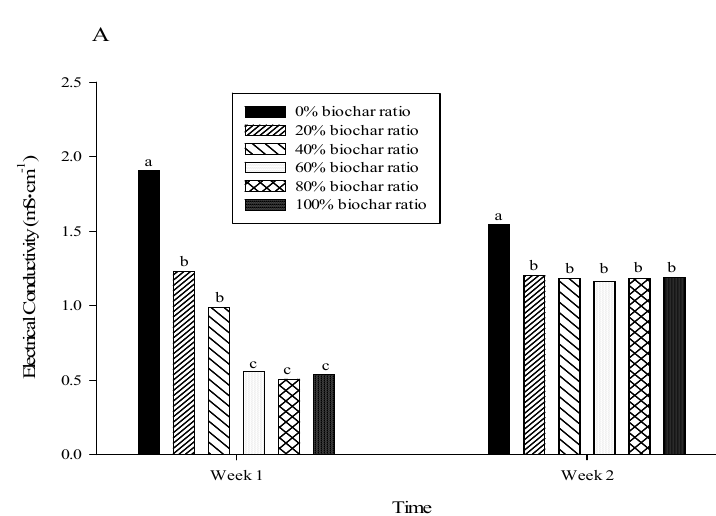
Figure 3. Week 1 and week 2 electrical conductivity (EC) of root substrate amended with biochar at different percentages. All plants were fertigated with 200 mg · L − 1 N. Columns followed by the same letter within week are not significantly different according to Student-Newman-Keuls multiple comparison at p ≤ 0.05 (week 1, six days after potting, and week 2, 13 days after potting).